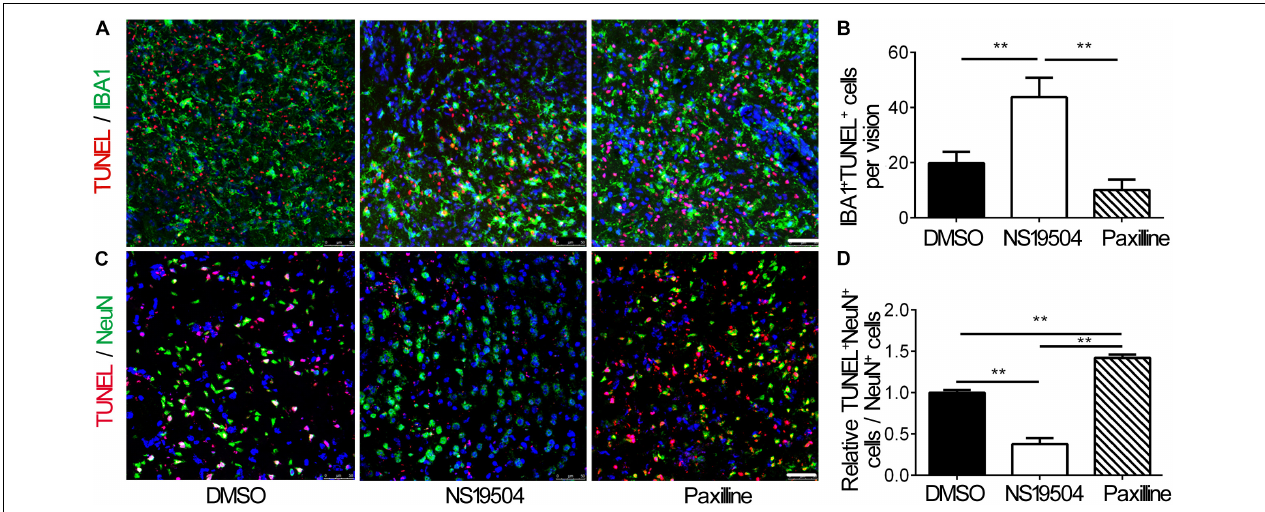
FIGURE 4 | Activation of BK channels promoted the phagocytic function of microglia after tMCAO and decreased neuronal apoptosis . (A) Representative photomicrograms of IBA1 + microglia (green) and TUNEL + apoptotic cells (red) in the peri-infarct region of brain slice in the DMSO, NS19504, and Paxilline groups at 3 days after tMCAO. Scale bar = 50 µ m. (B) Bar graph shows quantitative analysis of the number of IBA1 + TUNEL + cells per field. Data are mean + SE, n = 3 per group. *vs. DMSO group, ** p < 0.01. (C) Representative photomicrograms of NeuN + neurons (green) and TUNEL + apoptotic cells (red) in the peri-infarct region of brain slice in the DMSO, NS19504, and Paxilline groups at 3 days after tMCAO. Scale bar = 50 µ m. (D) Bar graph shows quantitative analysis of the number of NeuN + /TUNEL + cells per vision. Data are mean + SE, n = 3 per group. *vs. DMSO group, ** p < 0.01.